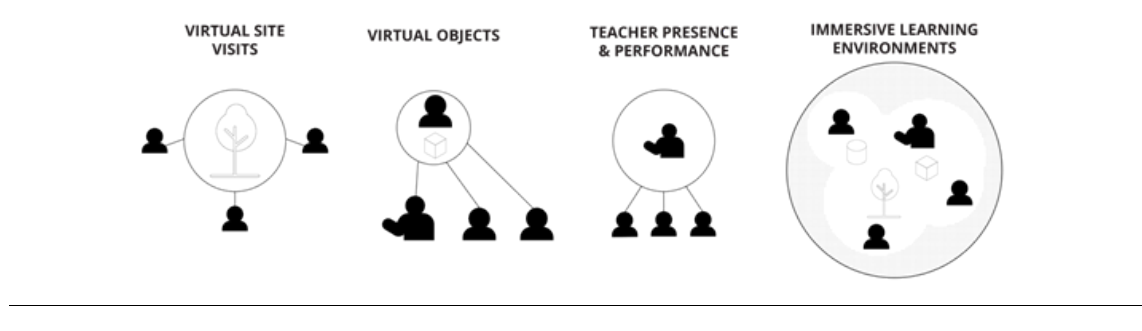
Figure 3. Models of learning relationships in virtual learning spaces (Source: Nancy Samayoa,